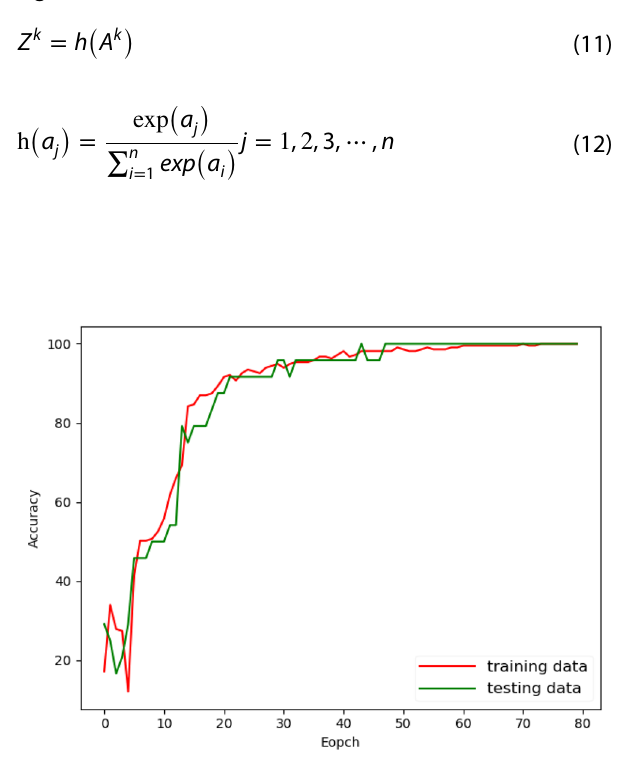
Fig. 9 Accuracy of test data and training data Fig. 10 Labeling of the vehicle